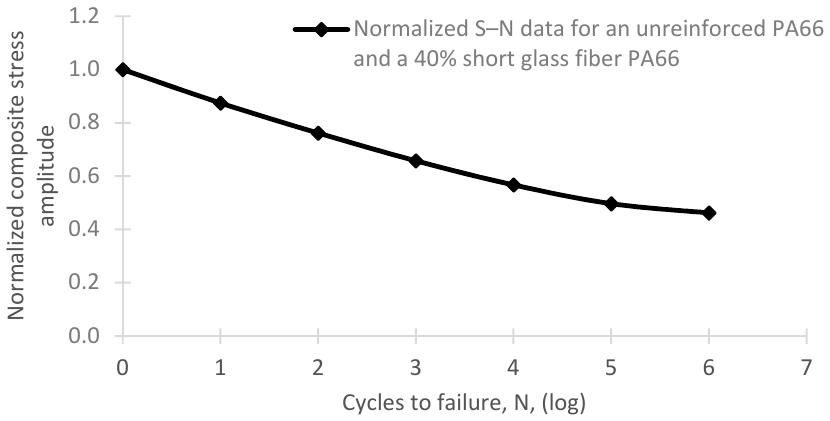
Figure 5. Normalized S-N curve assigned to the PA11 + 60% SGW composite. Adapted from [53].